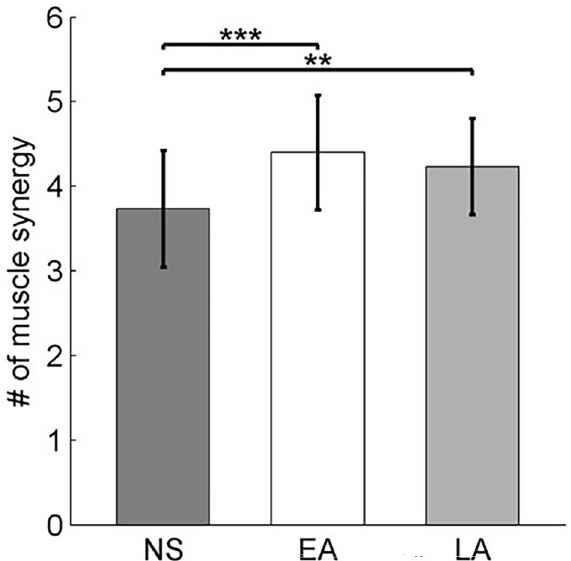
Figure 2. Number of muscle synergies (mean and SD) recruited for the novel-slip (dark gray bar), early- adaptation (white bar), and late-adaptation stages (light gray bar). ** denotes p < 0.01, *** denotes p <